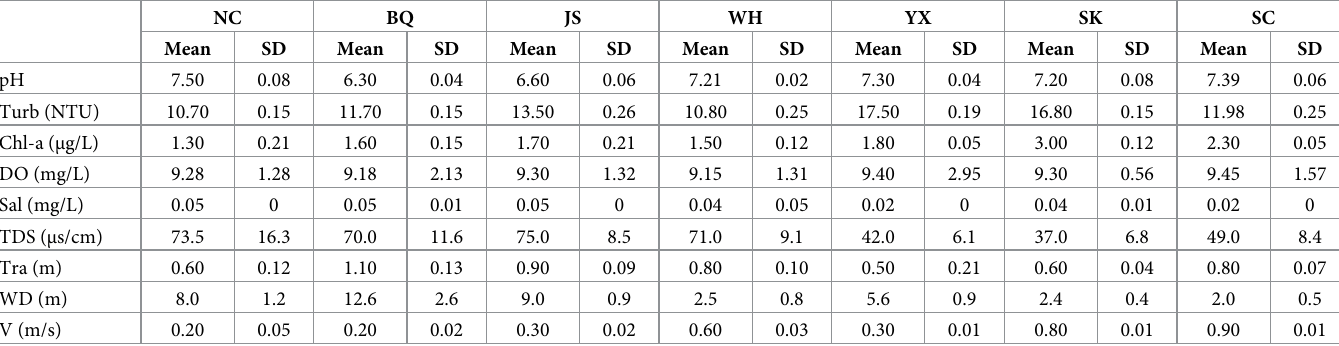
Table 3. Environmental factor changes in the middle and lower reaches of the Ganjiang